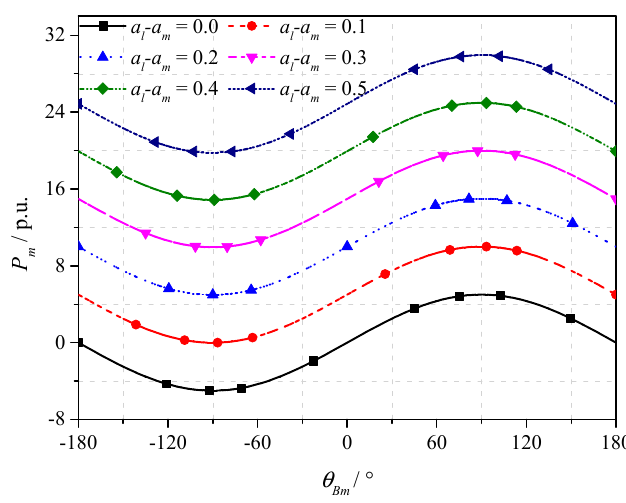
Figure 10. θ Bm - P m curve under different a l - a m .